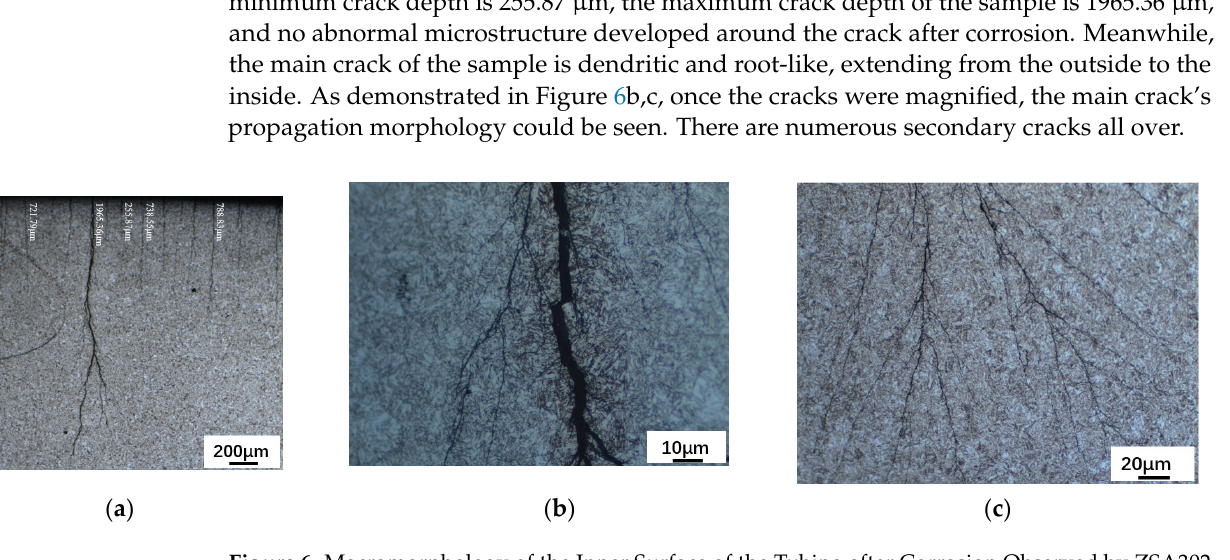
( b ) Figure 7. Micromorphology of Corrosion under Scale of Tubing (SEM). ( a ) Micromorphology of Corrosion Pits on Oil Pipe Surface. ( b ) Corrosion Microtopography of Tubing Section. The metallographic sample’s cross-section was magnified in a different position for more in-depth examination, as illustrated in Figure 8. After amplifying, it can be seen that pits in both figures develop into cracks. The parameters for the pitting shape in Figure 8a,b are 0.243 and 0.296, respectively. It is crucial to note that if the pitting form parameter